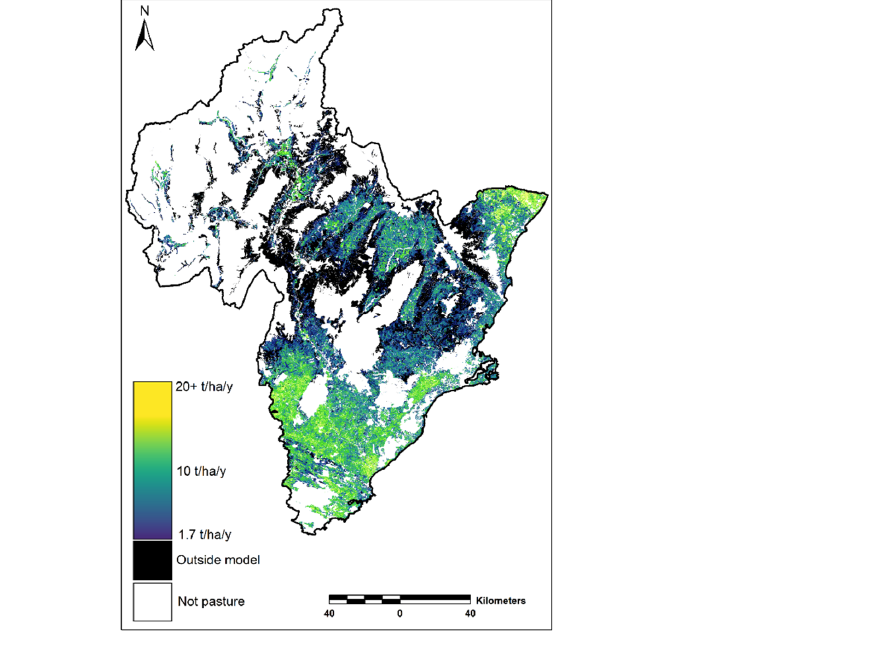
Figure 9. Taranaki pasture yield, with black areas having lower productivity than can be predicted by this model.